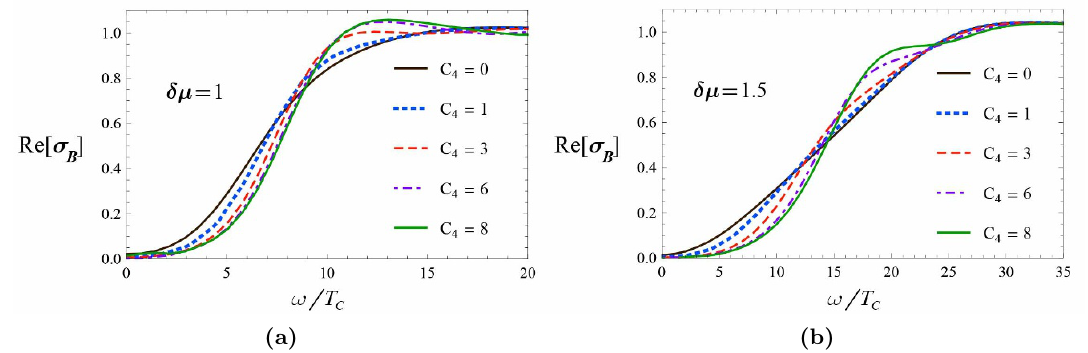
Figure 12. The real part of the spin conductivity in terms of !=T c for function F ( ) = 2 + C 4 4 with C 4 = 0 ; 1 ; 3 ; 6 ; 8 (solid curve, dotted curve, dashed curve, dot-dashed curve, and pale (green) solid curve). The conductivity of systems with (cid:14)(cid:22) = 1 and 1 : 5 are presented in the left and the right (cid:12)gure respectively.